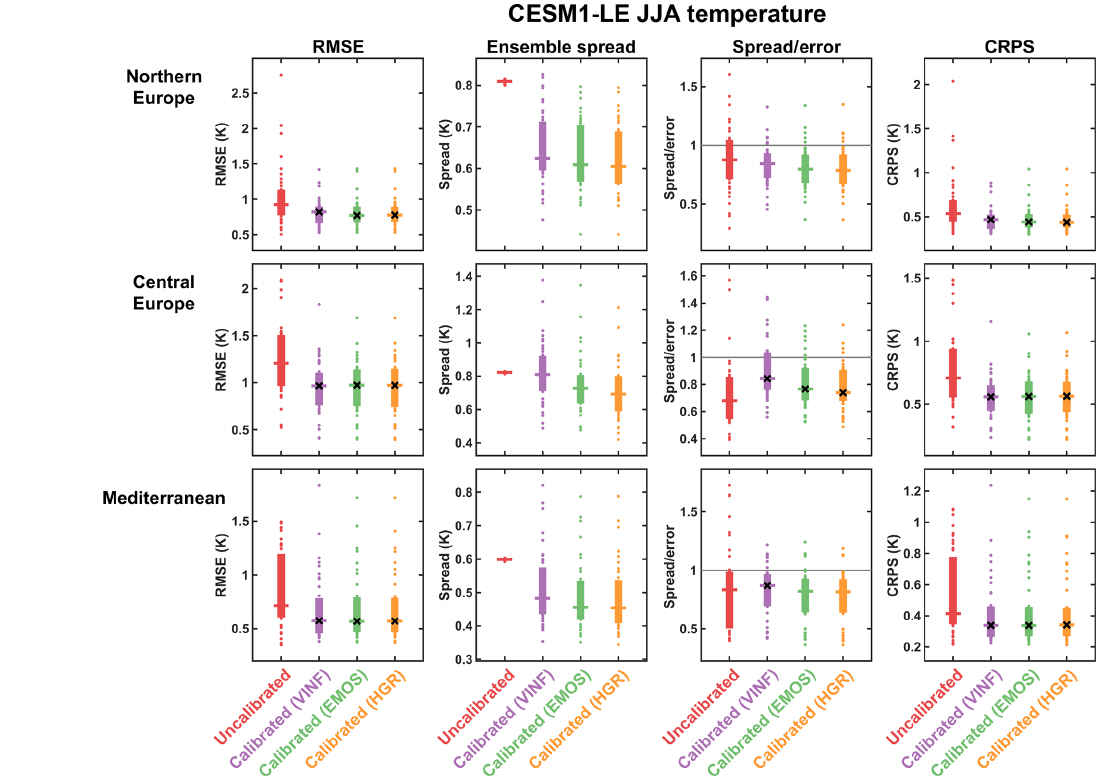
Figure 4. Comparison of calibration methods applied to the CESM1-LE summer temperature projections calibrated to the CMIP5 models over the observational period (1920–2016) and verified using the 44 years in the out-of-sample period (2017–2060). The verification statistics for each of the individual CMIP5 models are shown in dots, the interquartile range of this distribution is shown by the solid bars and the median is indicated by the horizontal lines. For the calibrated RMSE, spread / error ratio and CRPS values, the black crosses indicate where the calibration represents a significant improvement over the uncalibrated (but bias-corrected) ensemble at the 90% significance level. The significance levels were calculated using the non-parametric Mann–Whitney U test, applied to the distributions of the verification scores from the 39 CMIP5